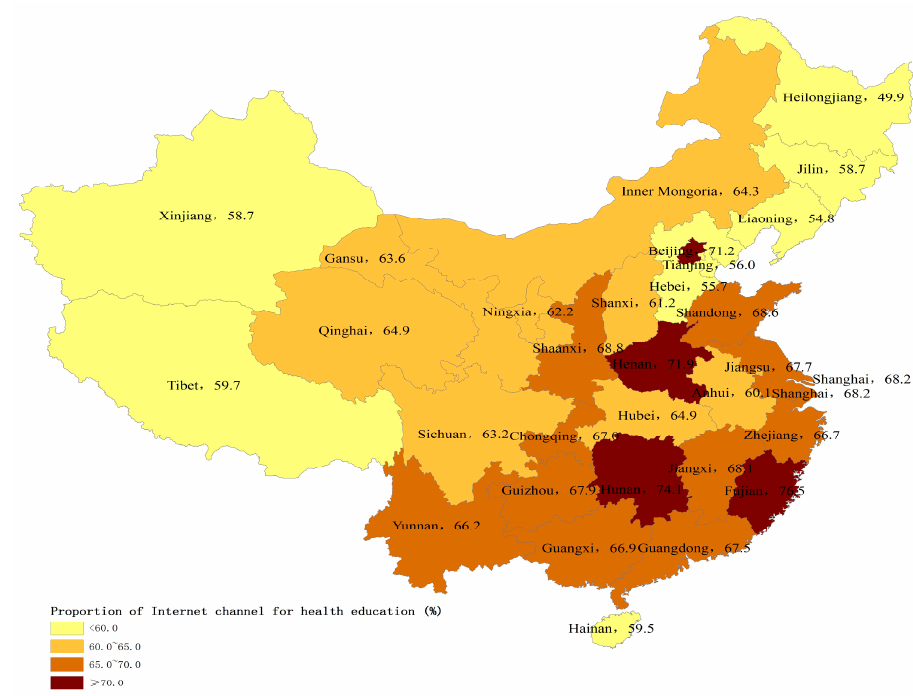
Figure 4. Percentage of internal migrants who had received health education through the Internet by province, 2015 (%).